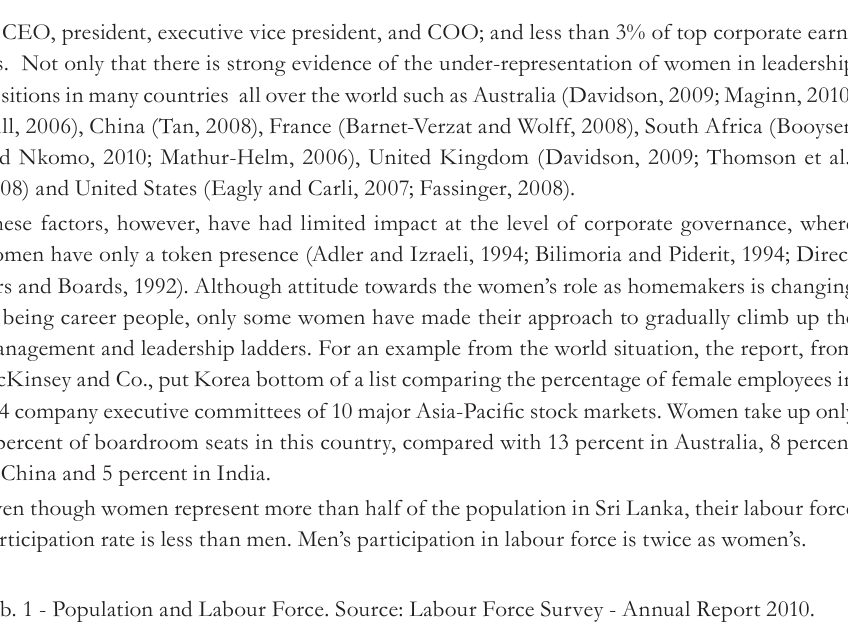
Tab. 1 - Population and Labour Force. Source: Labour Force Survey - Annual Report 2010. Population (10 years & over)